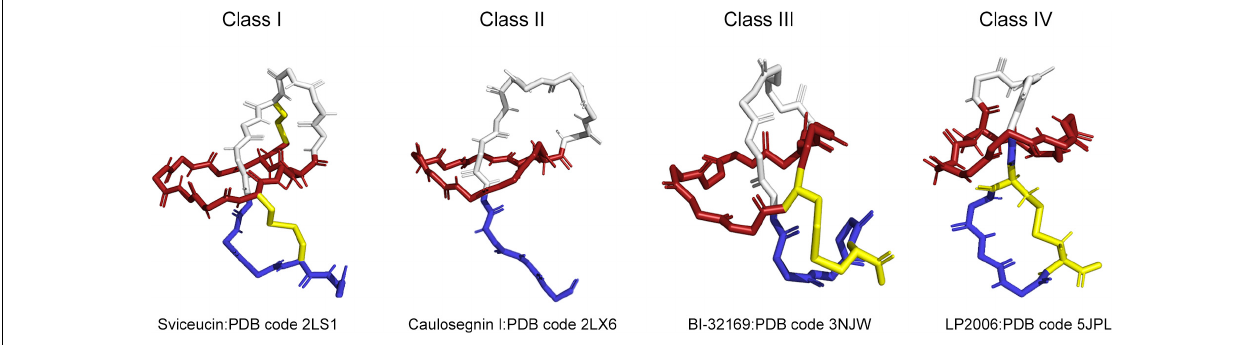
FIGURE 1 | Four types of lasso peptides demonstrated by representative structures (class I, class II, class III, and class IV). Sviceucin: PDB code 2LS1 for class I, caulosegnin I: PDB code 2LX6 for class II, BI-32169: PDB code 3NJW for class III, LP2006: PDB code 5JPL for class IV. The macrolactam ring is colored in red, the tail is in blue, the disulfide bonds are in yellow.